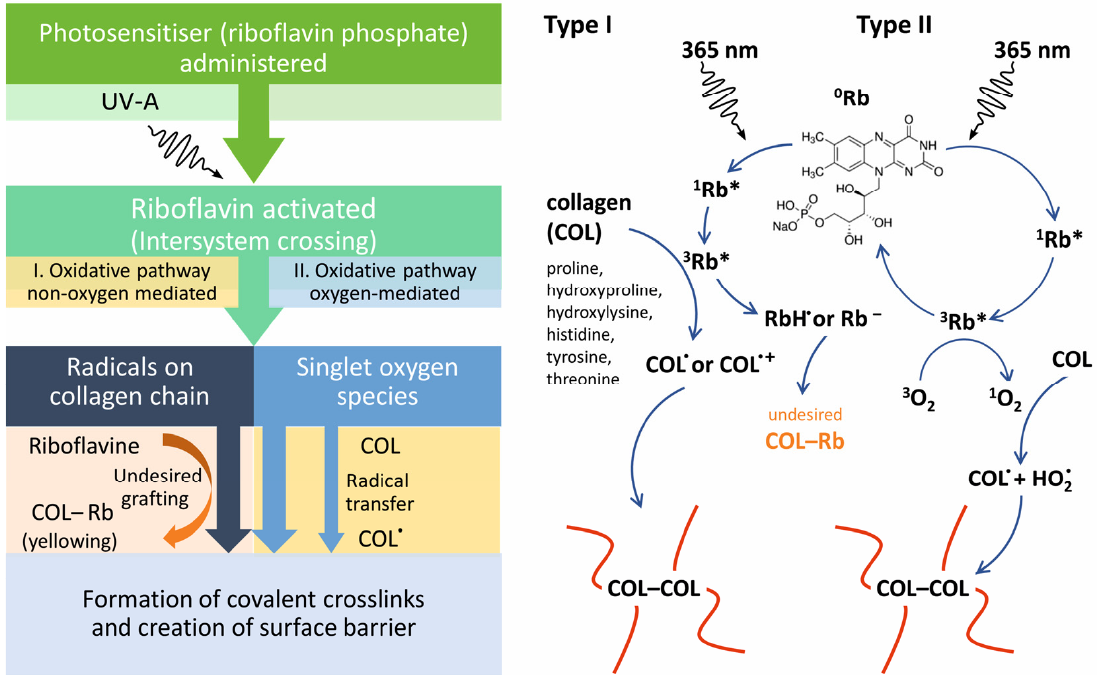
Figure 1. Scheme of crosslinking barrier creation on the surface of the lens ‐ shaped collagen drug carriers ( left ), chemistry of collagen crosslinking ( right ). Key: COL—collagen; Rb—riboflavin; Rb*— activated riboflavin.